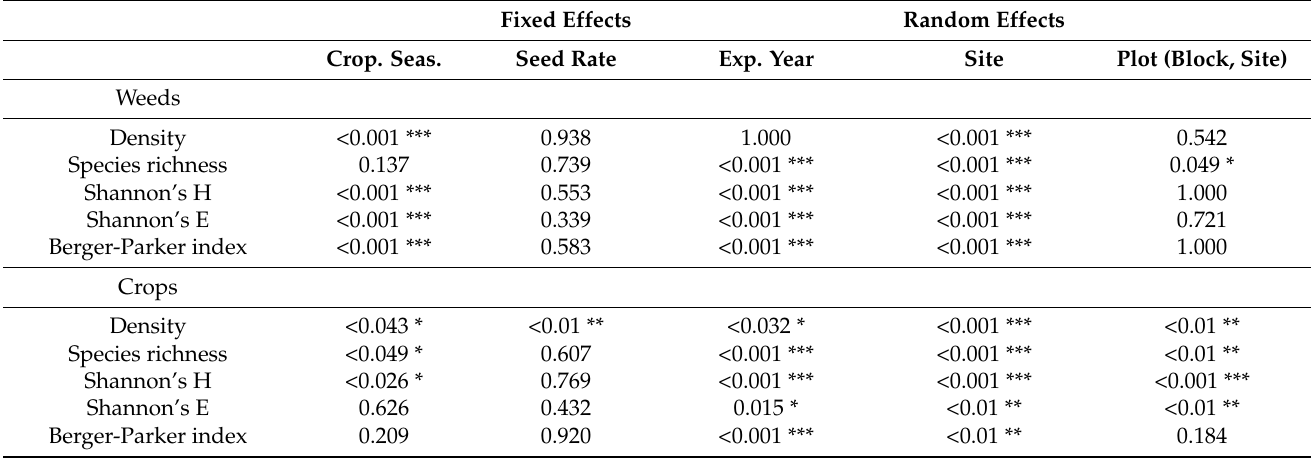
Table 4. Significance of the factors and their interactions, separated for weeds and crops. The interaction between cropping season and seed rate was tested, but no interaction was determined. The random factor block had no effect. (source: “emmeans” glm model output).